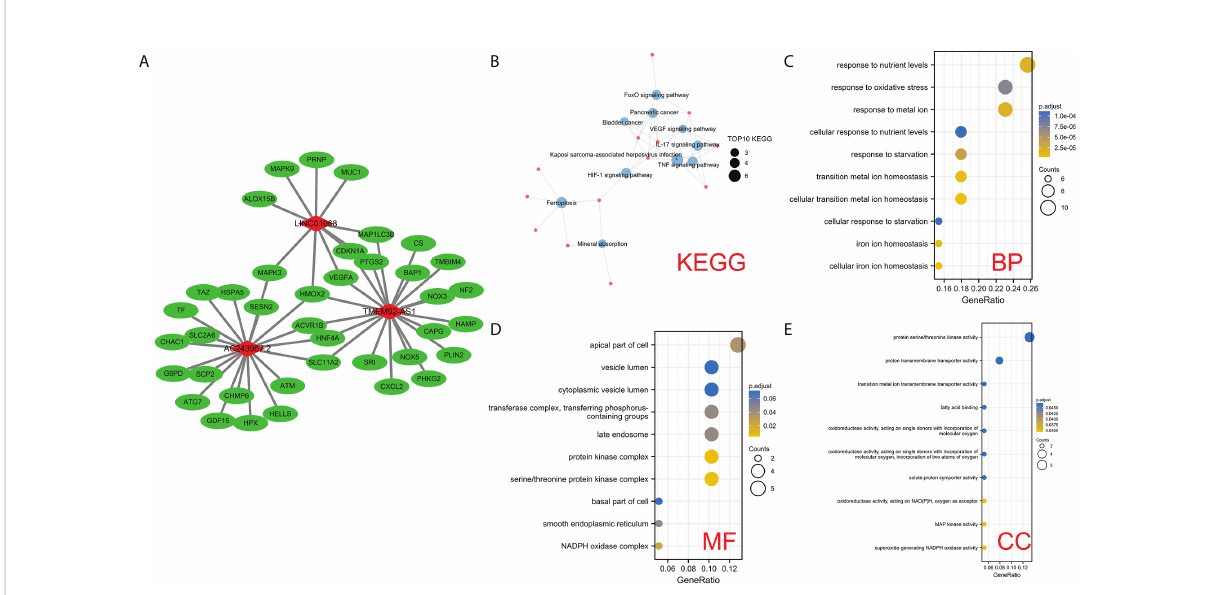
FIGURE 8 Analysis of the potential functions of 3 FIRLs. (A) Regulation network diagram of the 49 upstream coding FIRGs of 3 FIRLs. (B) KEGG enrichment analysis of 49 upstream FIRGs. (C – E) GO enrichment analysis of 49 upstream